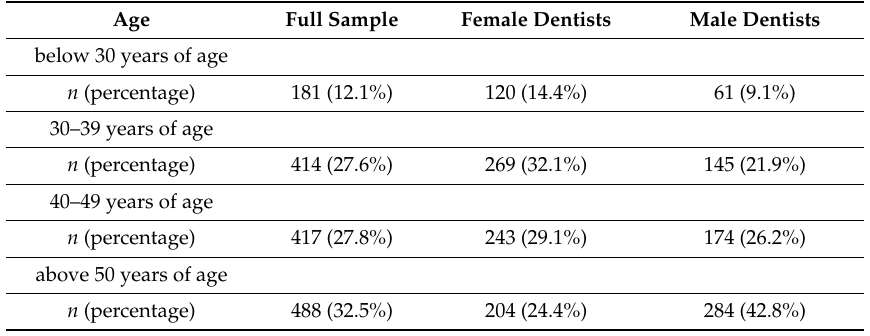
Table 1. Age distribution of respondents in the full sample according to gender.